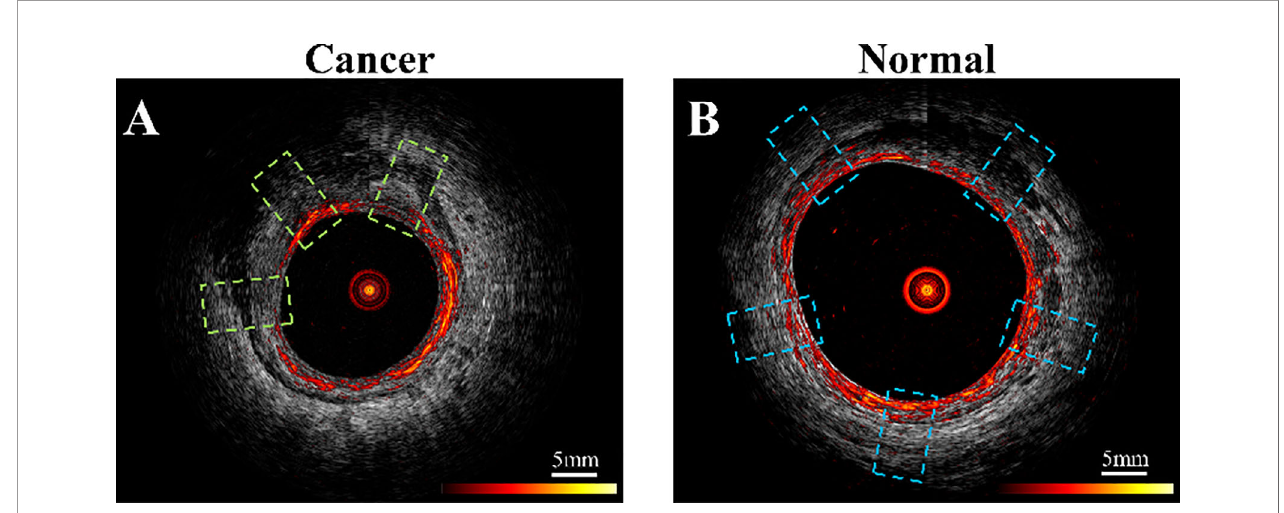
FIGURE 2 | Example co-registered PAM and US images showing ROIs of (A) residual cancer tissue, area in green dashed line boxes, and (B) normal tissue, area in blue boxes. PAM ROIs are cropped from PAM images, and US ROIs are cropped from US